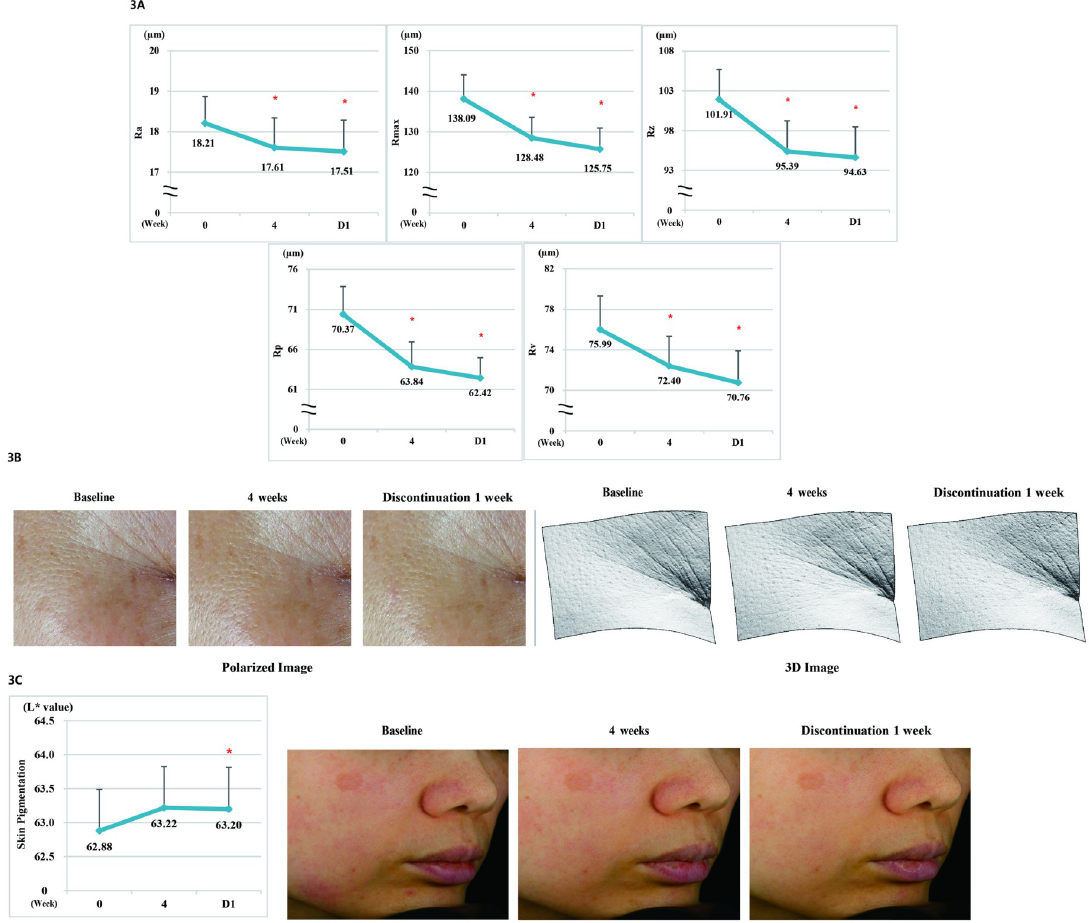
Fig 3. (A) Measurement of Average depth of wrinkles, Mean depth biggest wrinkles, Max. depth biggest wrinkles, Total wrinkle count, Total wrinkle volume, Total wrinkle area, Total length of wrinkles, Ra, and Rz parameters. (B) Polarized image and 3D image of Crow’s feet, nasolabial folds, forehead wrinkles. (C) F-RAY, the facial contour line image, and graph of the left cheek area. (D) Measurement of skin pigmentation. Cross-polarized image of the left cheek area. (E) Measurement of dermal density and ultrasonographic image of dermal density. (F) Effect for mechanical imprint (pressure) to skin and 3D image mechanical imprint (pressure) relief of the right cheek area.